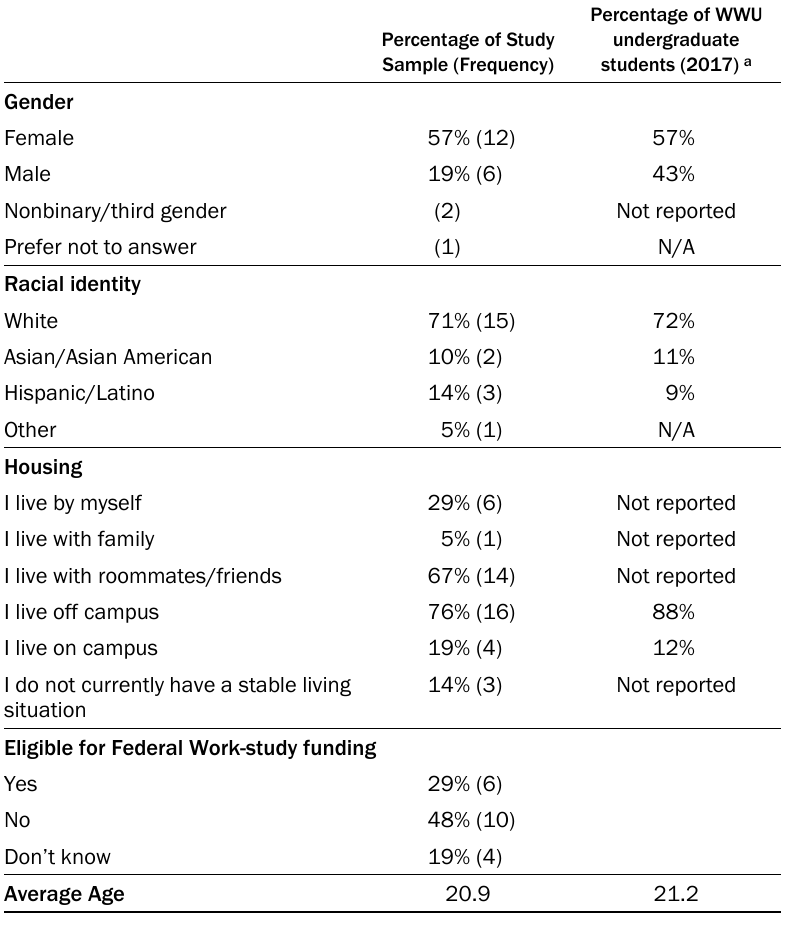
Table 2. Characteristics of Study Sample ( N